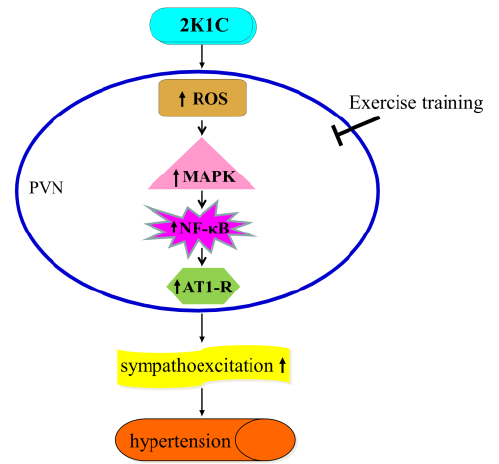
Figure 9. Graphical abstract of the mechanism of aerobic exercise training in ameliorating hypertension. ↑ : Increased expression.